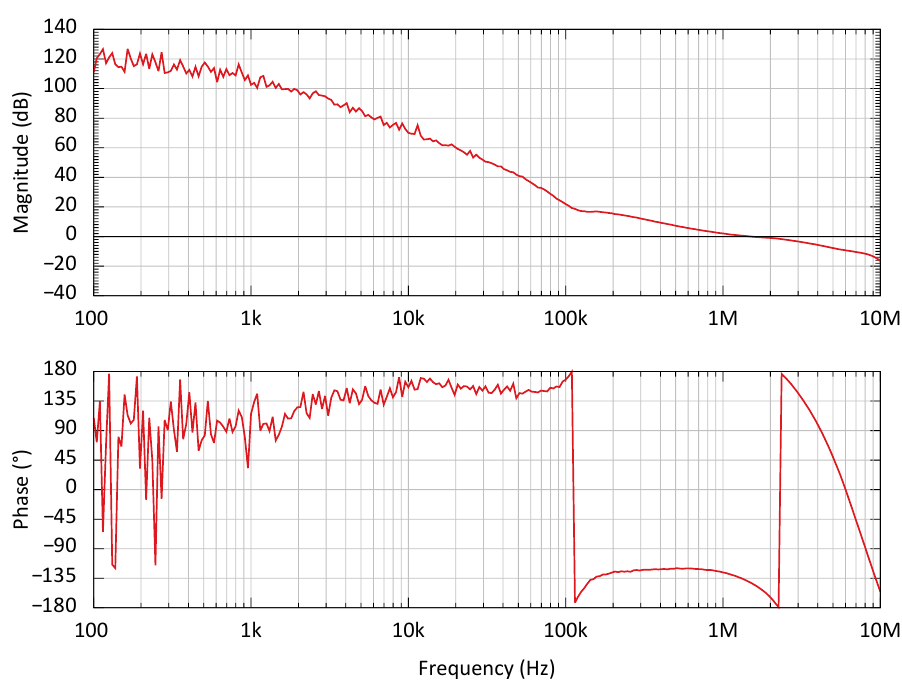
Figure 11. The open loop transfer function of the frequency stabilization of the laser to the resonance frequency of the reference cavity is shown. A unity gain bandwidth of 1.3MHz was achieved by utilizing a cross-over between feedback to the seed laser and to the fiber phase modulator at